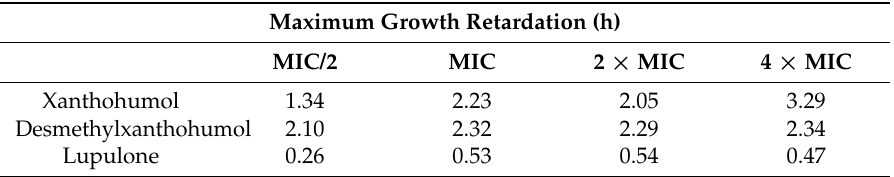
Table 5. Post-antibiotic effect on S. aureus T28.1 for each hops selected compound after 2 h exposure. Values are the maximum delayed growth retardation obtained after 3 independent experiments.